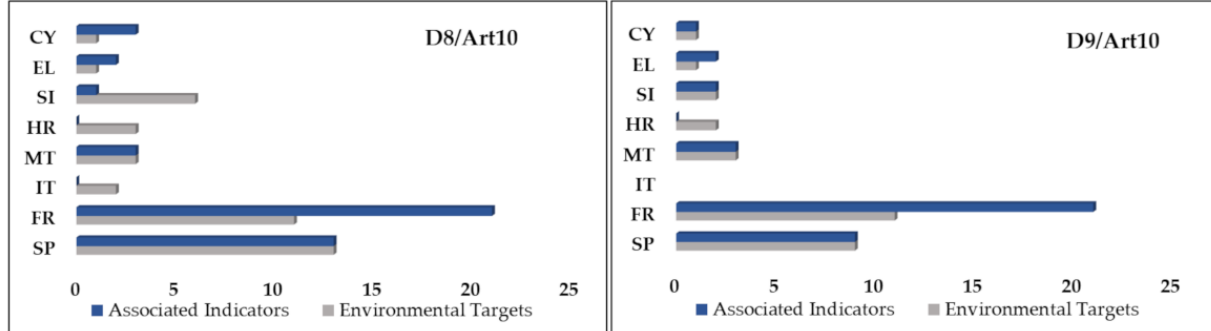
Figure 9. Environmental targets and associated indicators established by Mediterranean MSs for D8 and D9 in 2012.